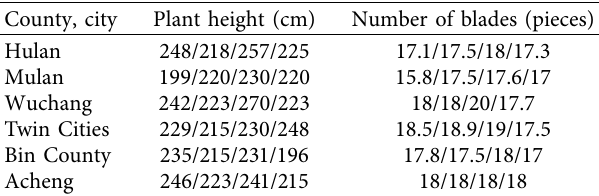
Table 2: Investigation form of corn growth monitoring (18/19/20/